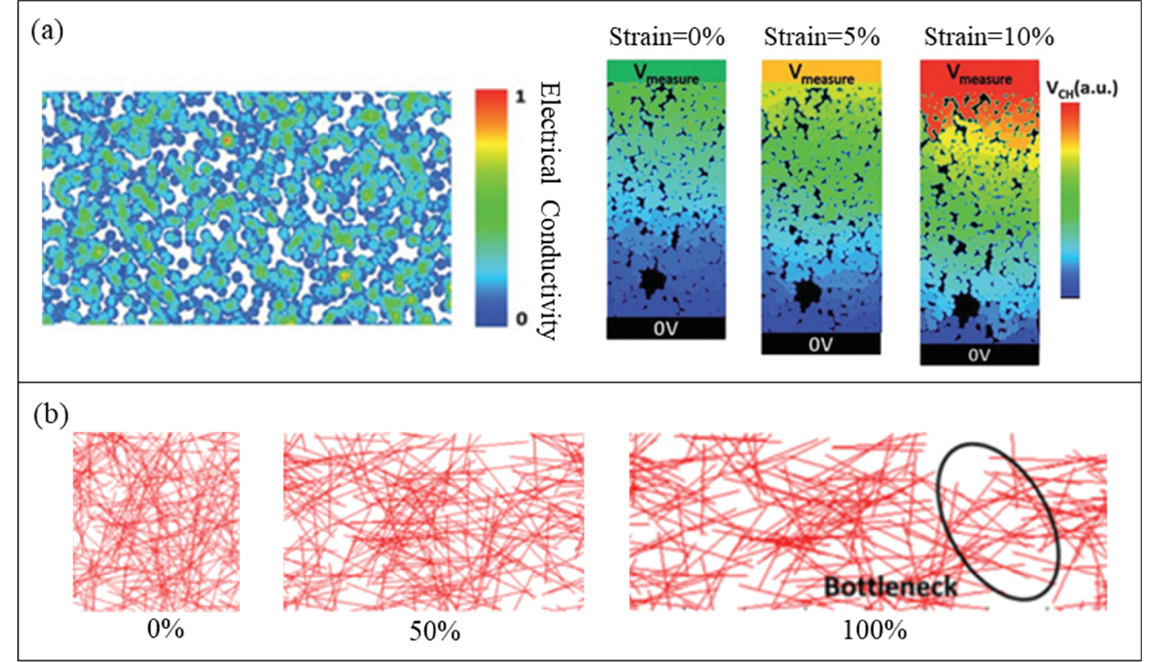
Figure 4. ( a ) percolation network of the randomly assigned graphene flakes [23] (Copyright 2019, Elsevier Ltd.); ( b ) percolation network of silver nanowires with low filler density [42] (Copyright 2016, WILEY-VCH).